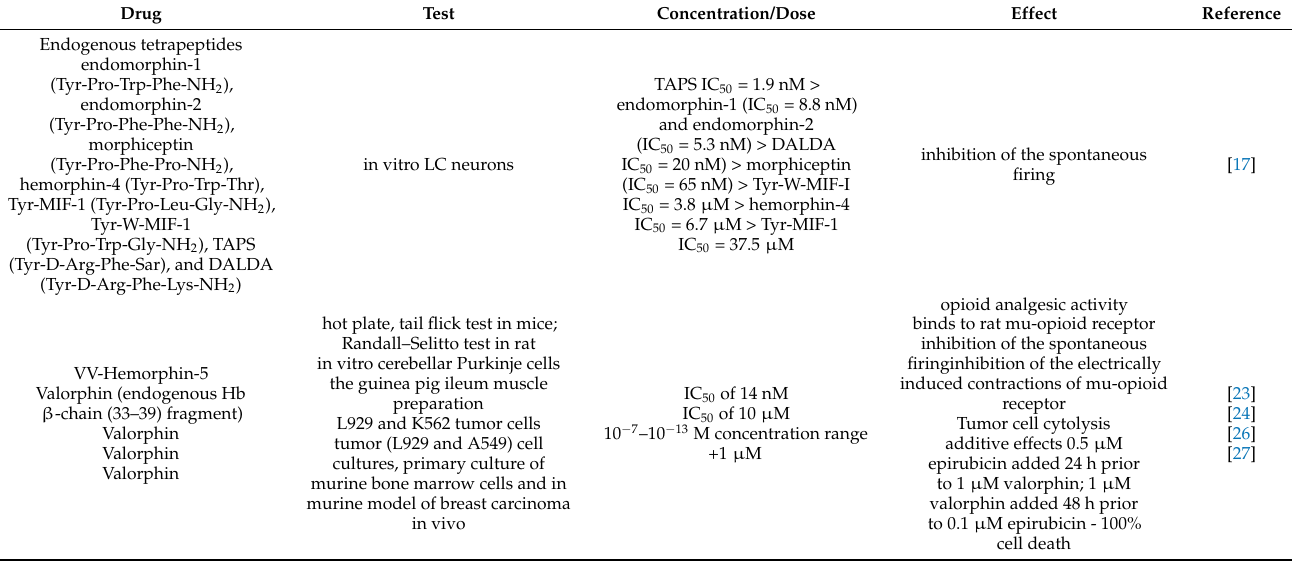
Table 5. Bioactive hemorphin